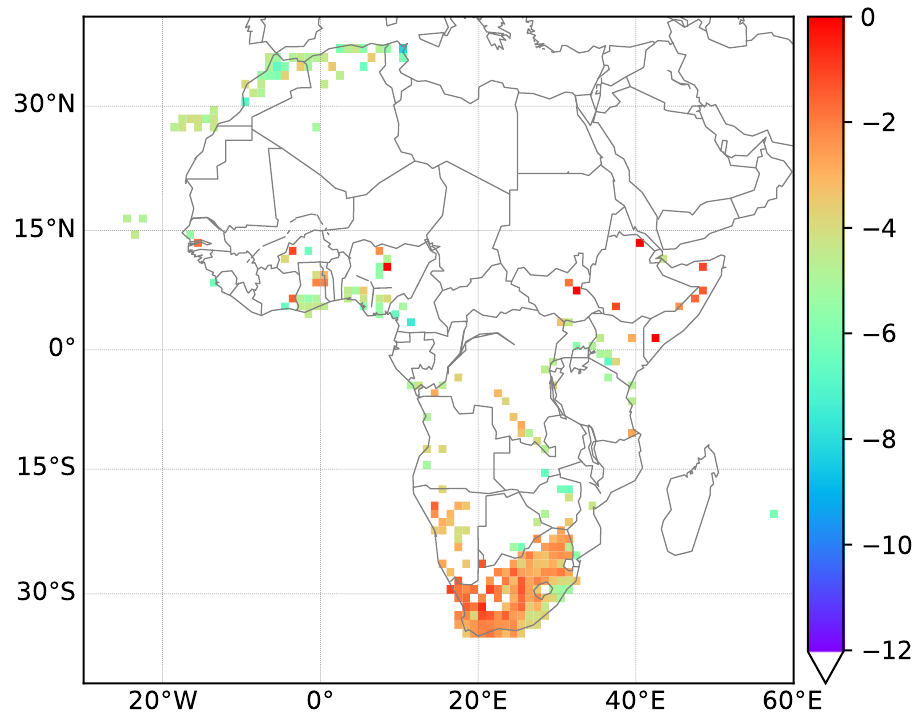
Figure 12. Heatmap of Africa showing the density of streets mapped to Dutch street specifics. Colors indicate the density of streets in this area, thus the logarithmic value of the number of streets normalized by all streets in the cell of the grid.